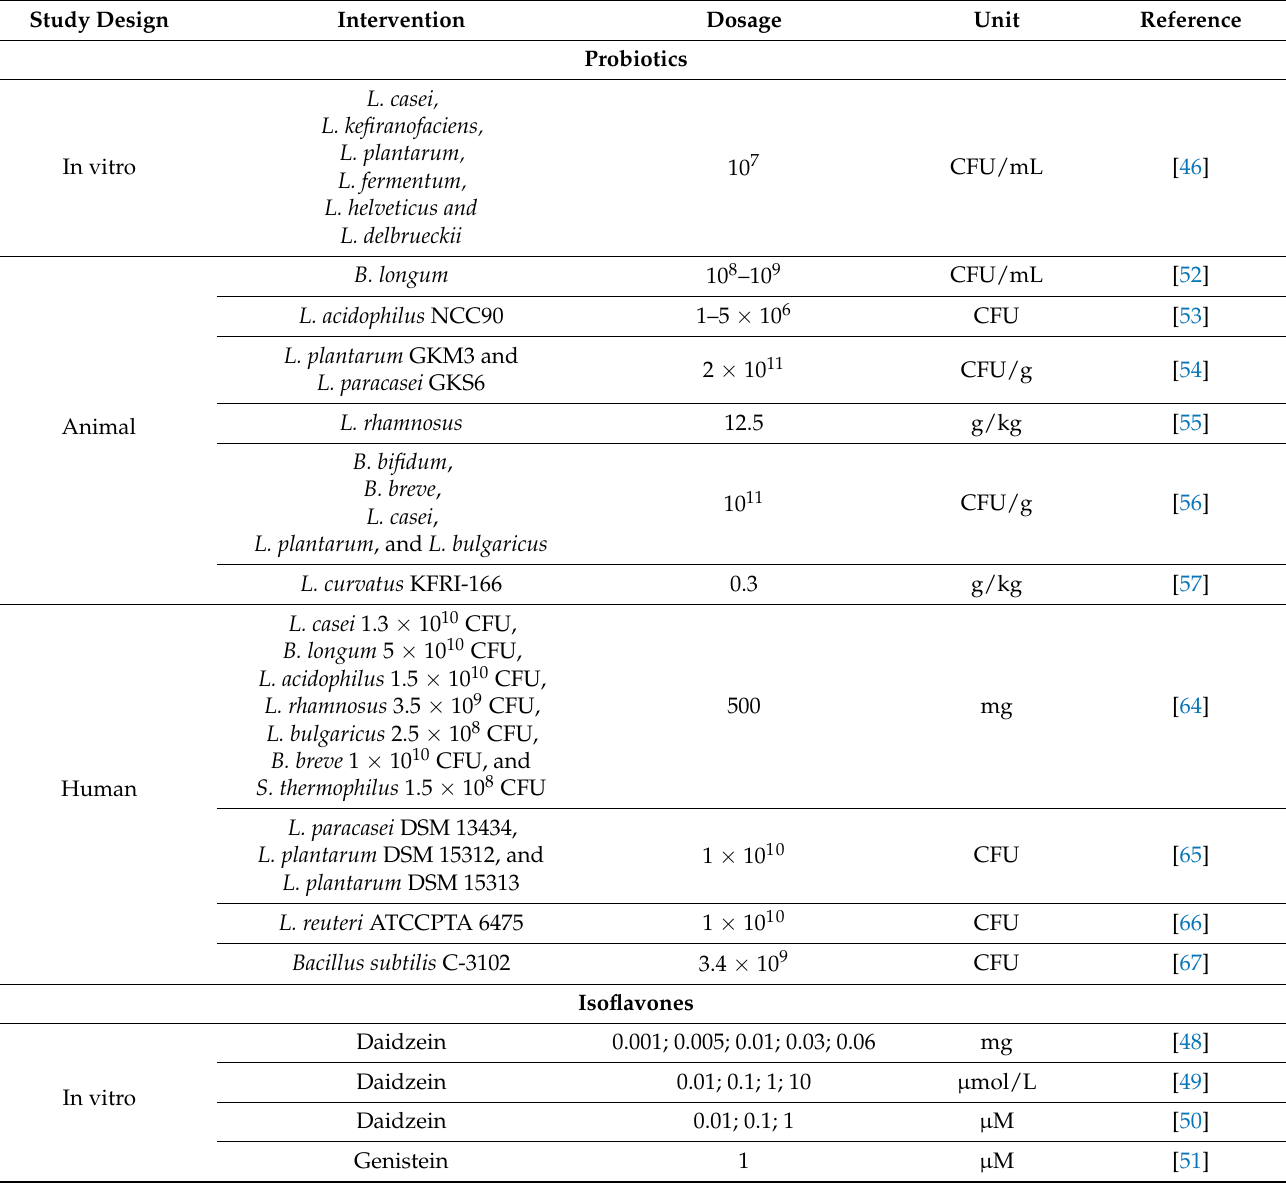
Table 6. Dosage intervention of probiotics and isoflavones in in vitro, animal, and human studies. Study Design Intervention Dosage Unit Reference